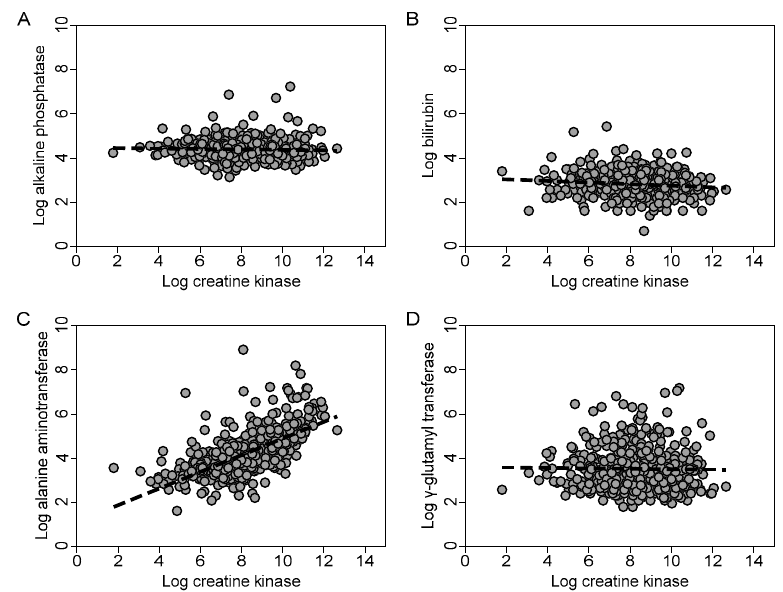
Figure 2. Effect of logarithmic transformation on the distribution of peak CK and ALT. Histograms demonstrate the distribution of the raw peak CK ( A ) and raw ALT ( B ), and the distribution after logarithmic transformation with a superimposed normal distribution curve for CK ( C ) and ALT ( D ).